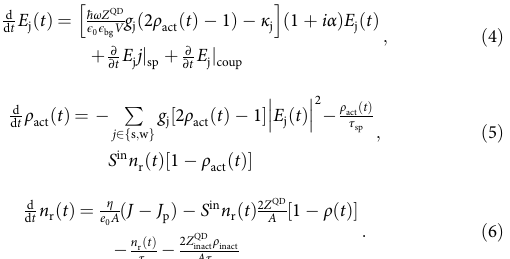
120 micropillar array, but the exact current through a speci fi c micropillar is not known Figure 8a presents the experimental setup which is used to study the mutual coupling of micropillar lasers via symmetric paths. Emission of each microlaser is fi rst collimated by an aspheric lens with signi fi cantly reduced transmission losses if compared to usually used long working-distance microscope objectives and is then directed by beam-splitters with 90% re fl ectivity to the other microlaser of the selected pair. We would like to note that the use of an aspheric lens is crucial to achieve a high enough optical power level for the mutual coupling experiments between the microlasers. The transmitted light (10%) is directed via a PBS toward the two detection paths. Using polarization optics, it is possible to independently select the micropillar modes (strong and weak) being coupled and also those being detected. An optional variable attenuator (VarAtt) in the coupling path enables control of the coupling strength. In an alternative version of the experiment, which aims at the demonstration of zero-lag synchronization, the variable attenuator is substituted by a passive relay (pellicle mirror with 50% transmittance) placed in the center of the beam path between both pillars. The required submicrometer mechanical stability of the coupling beam path between the pillars with microscale upper facets is ensured by a customized video control loop in which the microscopic image of each sample was constantly monitored by a computer such that (unavoidable) temperature-induced sample shifts were automatically compensated by tracking the motorized linear stages of the corresponding cryostat.